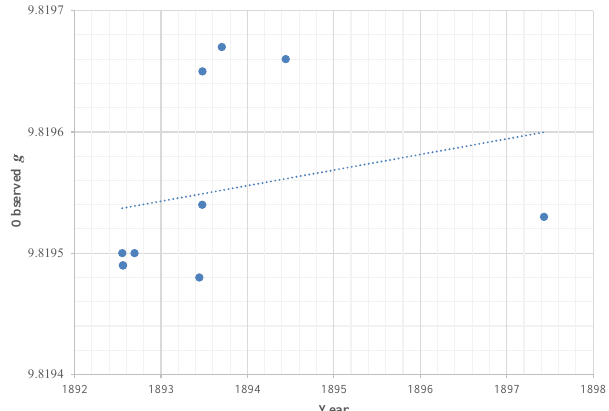
Figure 2. Repeated gravity observations at the reference site in the Oslo University